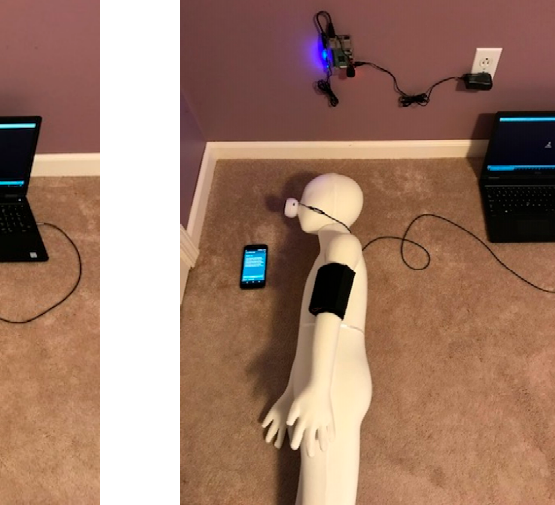
Table 2. Comparison with other works.